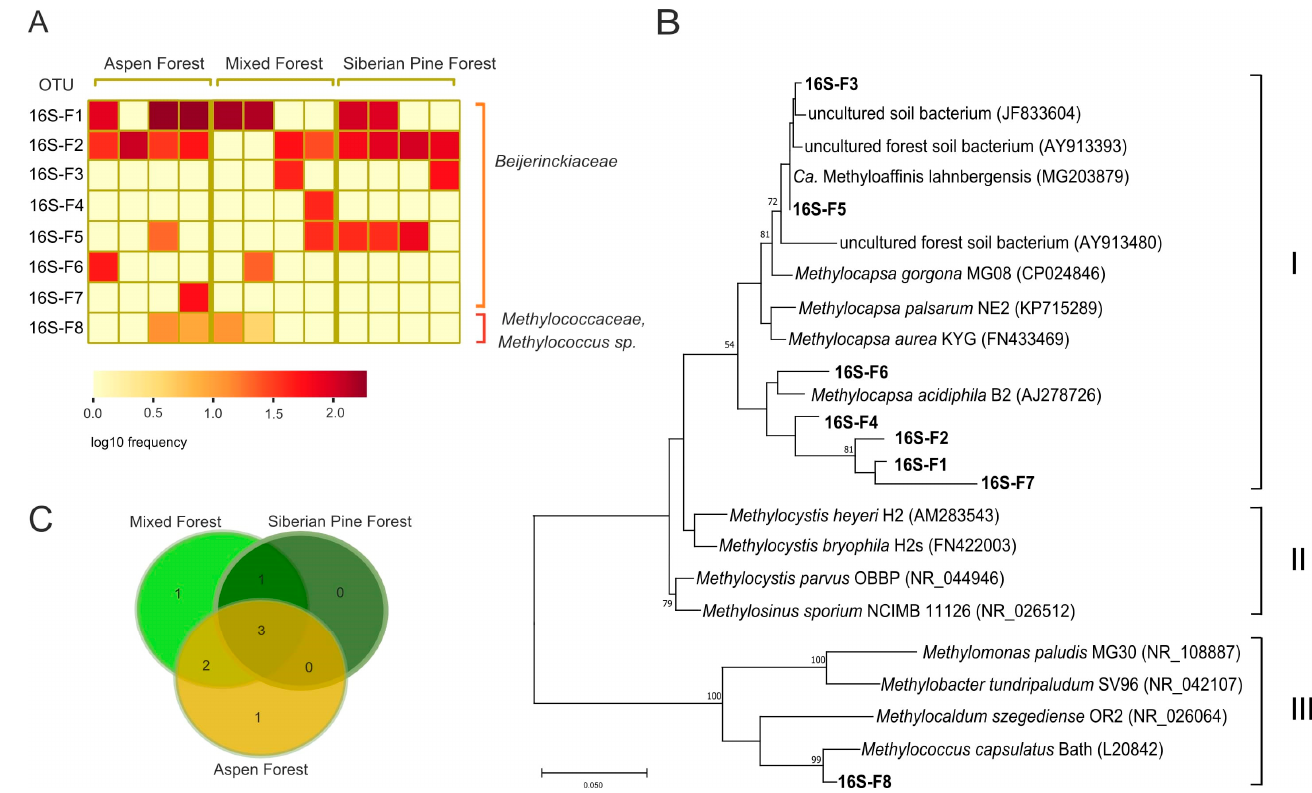
Figure 6. ( A ) Heatmap of the relative abundance of methanotrophic bacteria displayed according to the proportion of the corresponding 16S rRNA gene fragments retrieved from each forest sample. ( C ) 16S rRNA gene-based tree showing the phylogenetic position of OTUs identified in this study; I, Beijerinckiaceae ; II, Methylocystaceae ; III, Methylococcaceae . ( B ) The Venn diagram showing distribution of 16S rRNA gene-based OTUs of methanotrophs between different forest types.